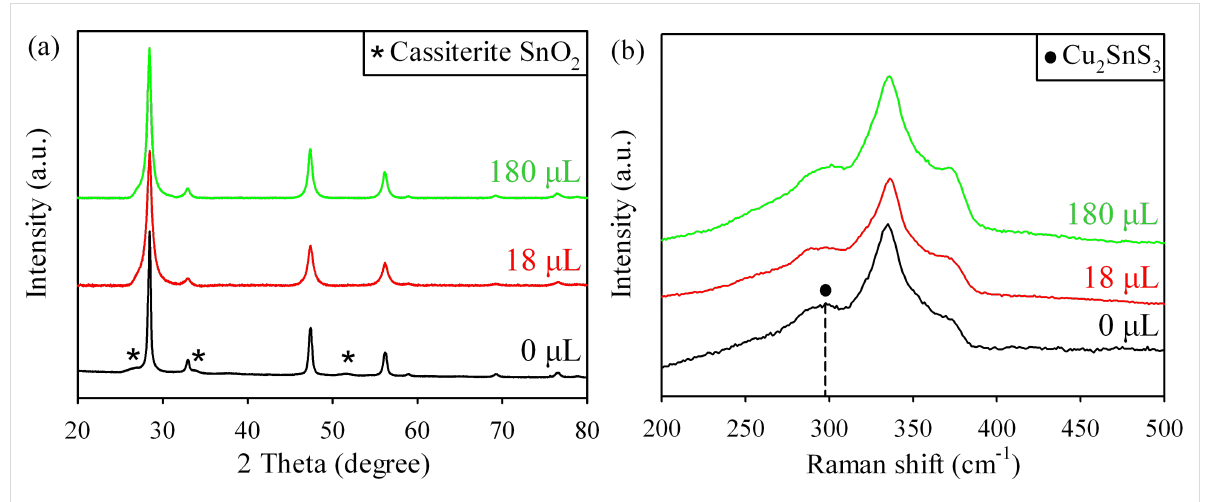
Figure 3: (a) XRD patterns and (b) Raman spectra of the hydrothermal products synthesized with different TGA concentration in the precursor solu- tion.